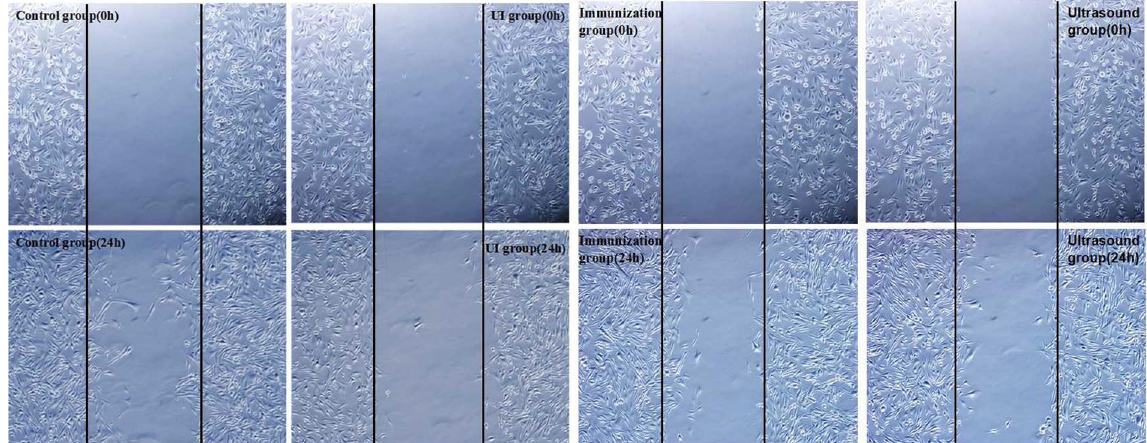
Figure 5. RM-1 cells in the control group has dispersed into the scratch area. Cell migration by the UI group was not obvious; a certain number of cells crossed the line in the immunization group and ultrasound group ( × 100).